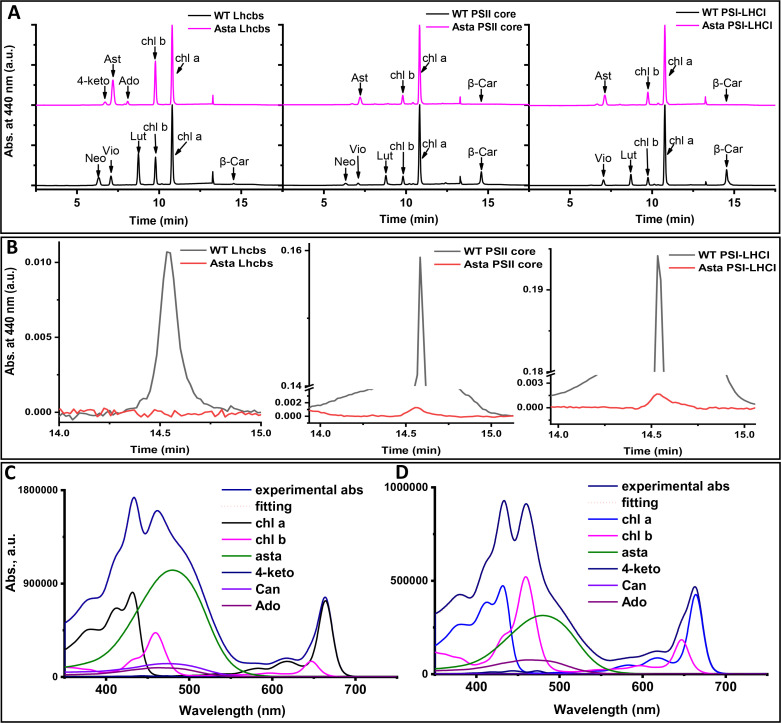
Pigment analysis.(A) The chromatographic profiles were recorded at 440 nm with 4 nm of bandwidth and normalized to the Chl a peak. (Neo: neoxanthin, Vio: violaxanthin, Lut: lutein, β-Car: β-carotene, 4-keto: 4-ketoantheraxanthin, Ast: astaxanthin, Ado: adonixanthin, Can: canthaxanthin). The presence of Chl b in the PSII core is the result of some contamination form Lhcbs in the preparation. (B) Zoom in the β-Car area of panel A. Note the difference in scale between the chromatogram of the WT and that of the mutant for PSI and PSII complexes. (C and D) Examples of fitting of the absorption spectrum of the acetone extract with the spectra of the individual pigments. (C) Thylakoids from young leaves of the mutant. (D) Asta-LHCs. The spectra measured in 80% acetone.